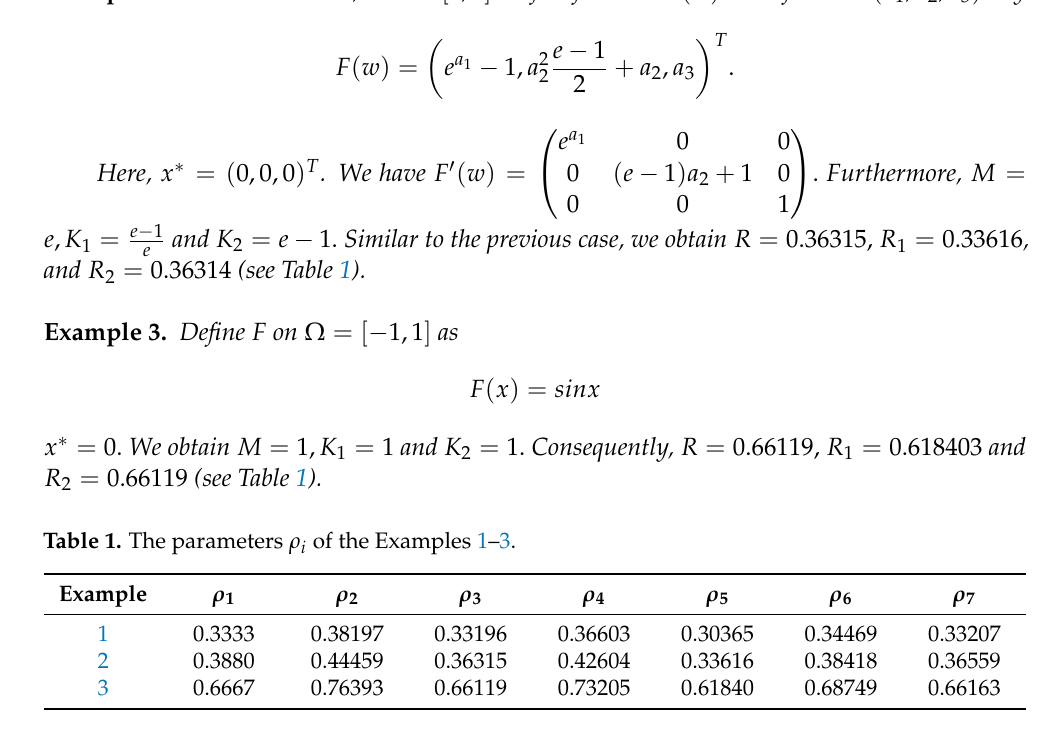
Table 2. ACOC of Examples 2 and